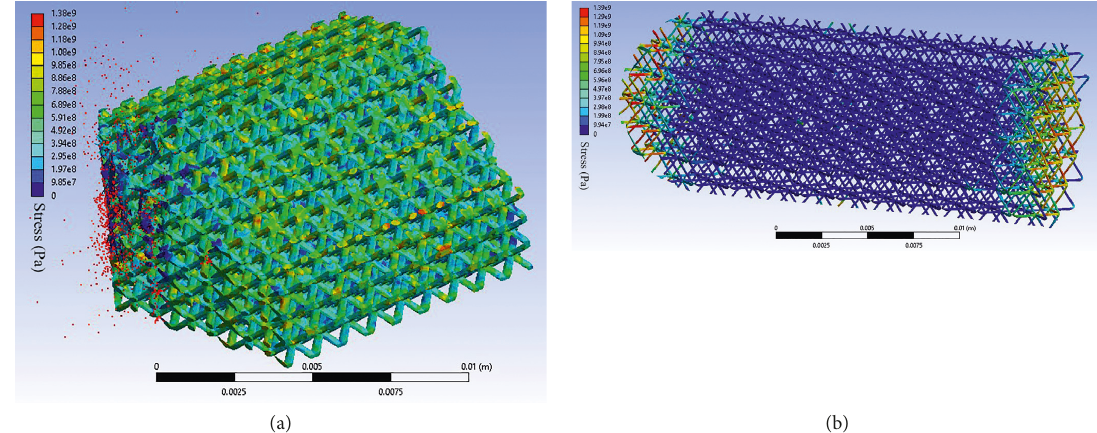
Figure 19: Von Mises stress distribution of lattices shown separately for the conditions of abrasion (a) and impact